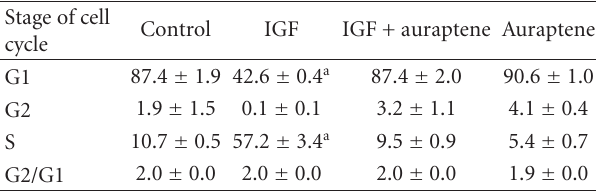
Table 2: Average percentage of cells at 24h time point.